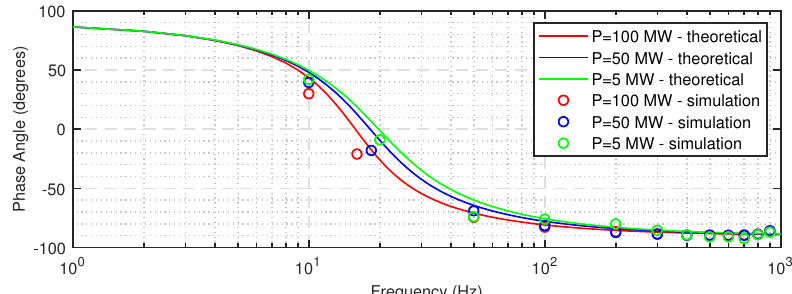
Figure 15. DAB Impedance Magnitude Validation.